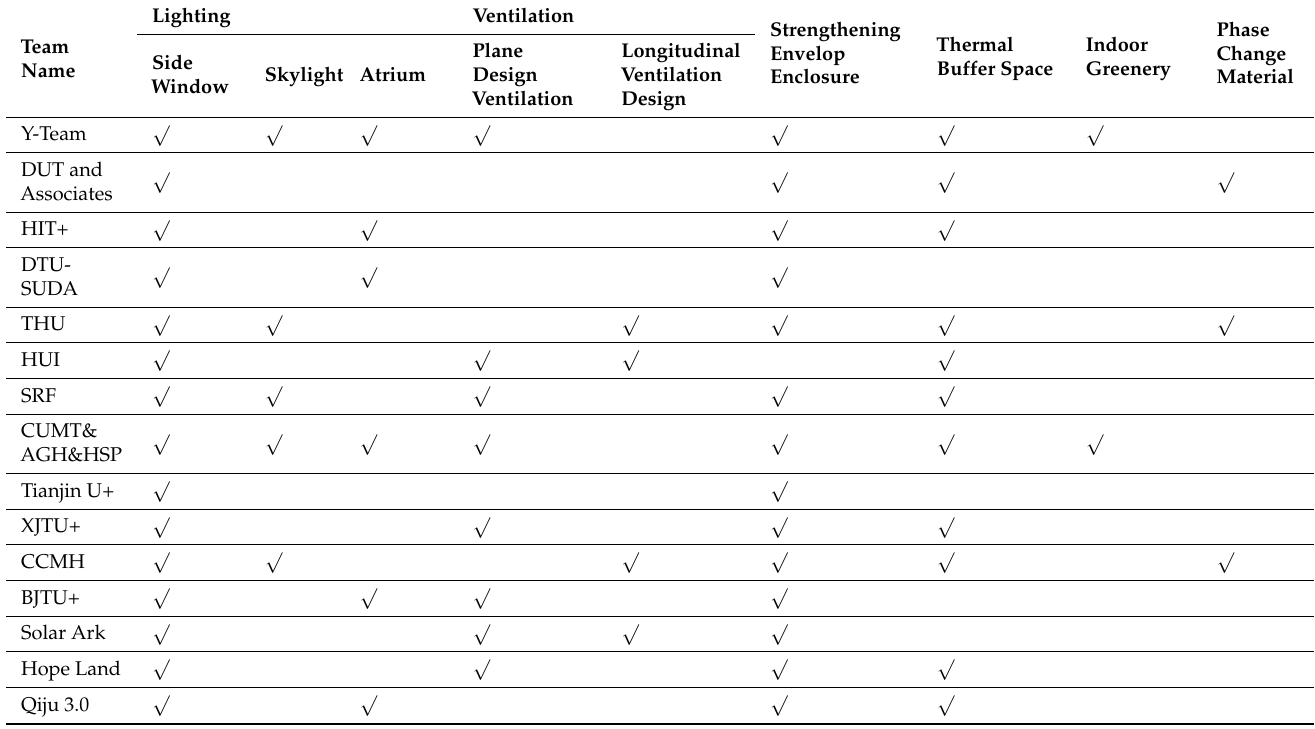
Table 5. Application of passive temperature regulation